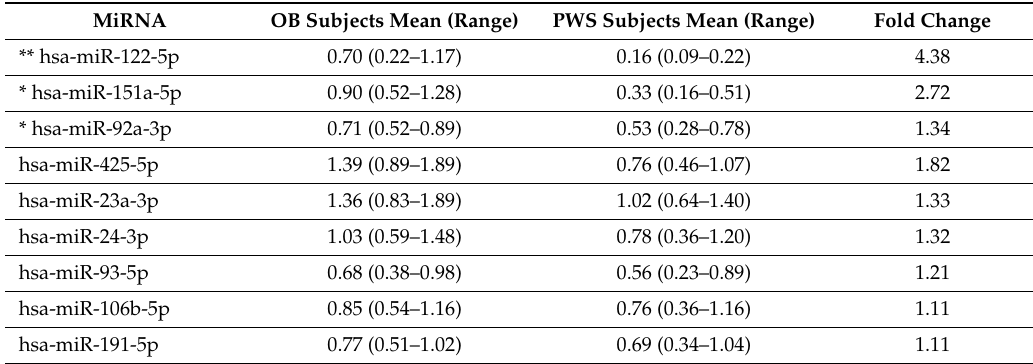
Table 1. Relative mean ∆∆ Cq expression of serum miRNAs of obesity (OB) and Prader–Willi syndrome (PWS) subjects.